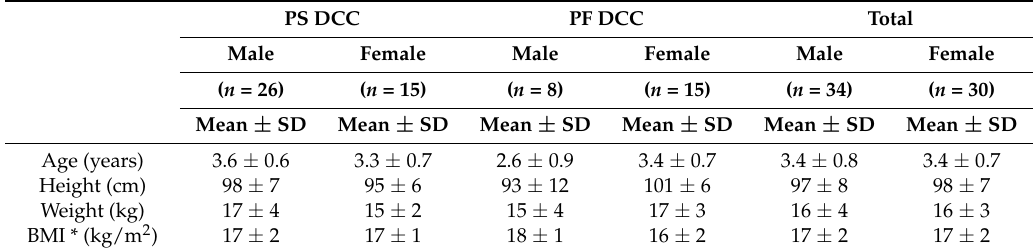
Table 2. Anthropometric characteristics of children from the day care centers (DCC) PS and PF (S ã o Paulo,